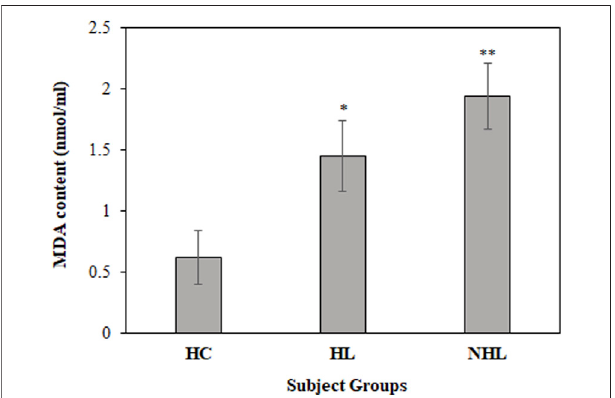
FIGURE3| DetectionofMDAcontentlevelsinserumsamplesofHLand NHL subjects.Serum samplesfrom healthyindividualswereused ascontrols. * p < 0.05 and ** p <